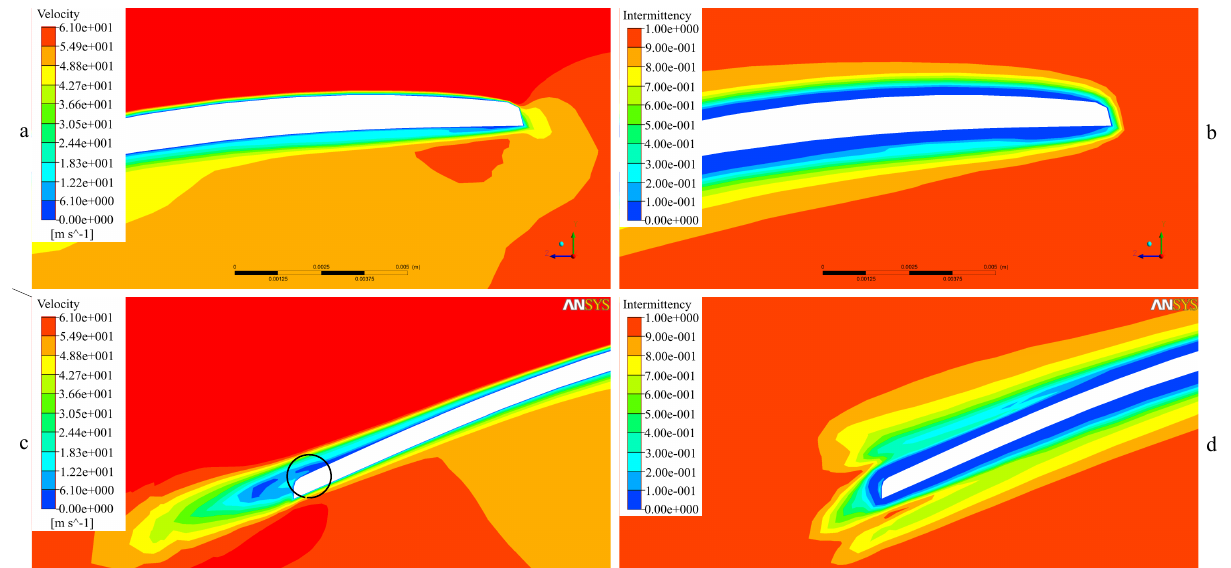
Figure 15. Velocity and intermittency contours at mid-span for operation at Re = 1.15 × 10 5 . ( a ) Ve- locity at the leading edge, ( b ) intermittency at the leading edge, ( c ) velocity at the trailing edge, ( d ) intermittency at the trailing edge.